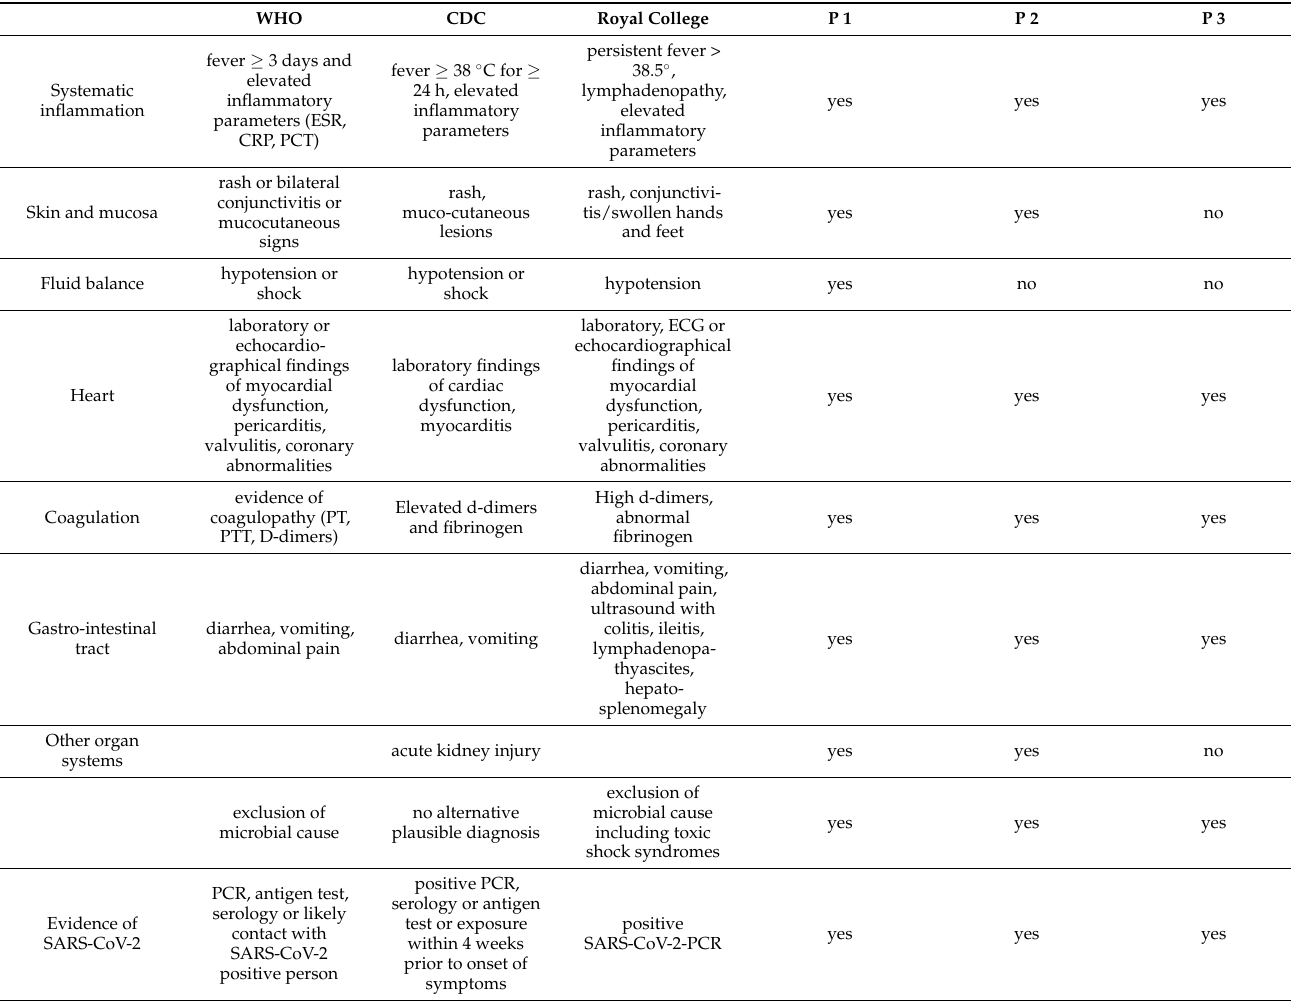
Table 1. MIS-C case-related definitions and clinical patient characteristics of patients 1–3 (P1–3) [19–21]. For the diagnosis of MIS-C not all symptoms must be